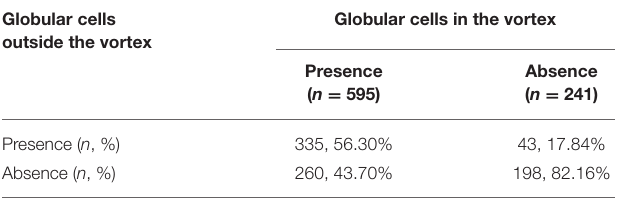
TABLE 1 | Distribution of the globular cells in and outside the corneal nerve vortex.